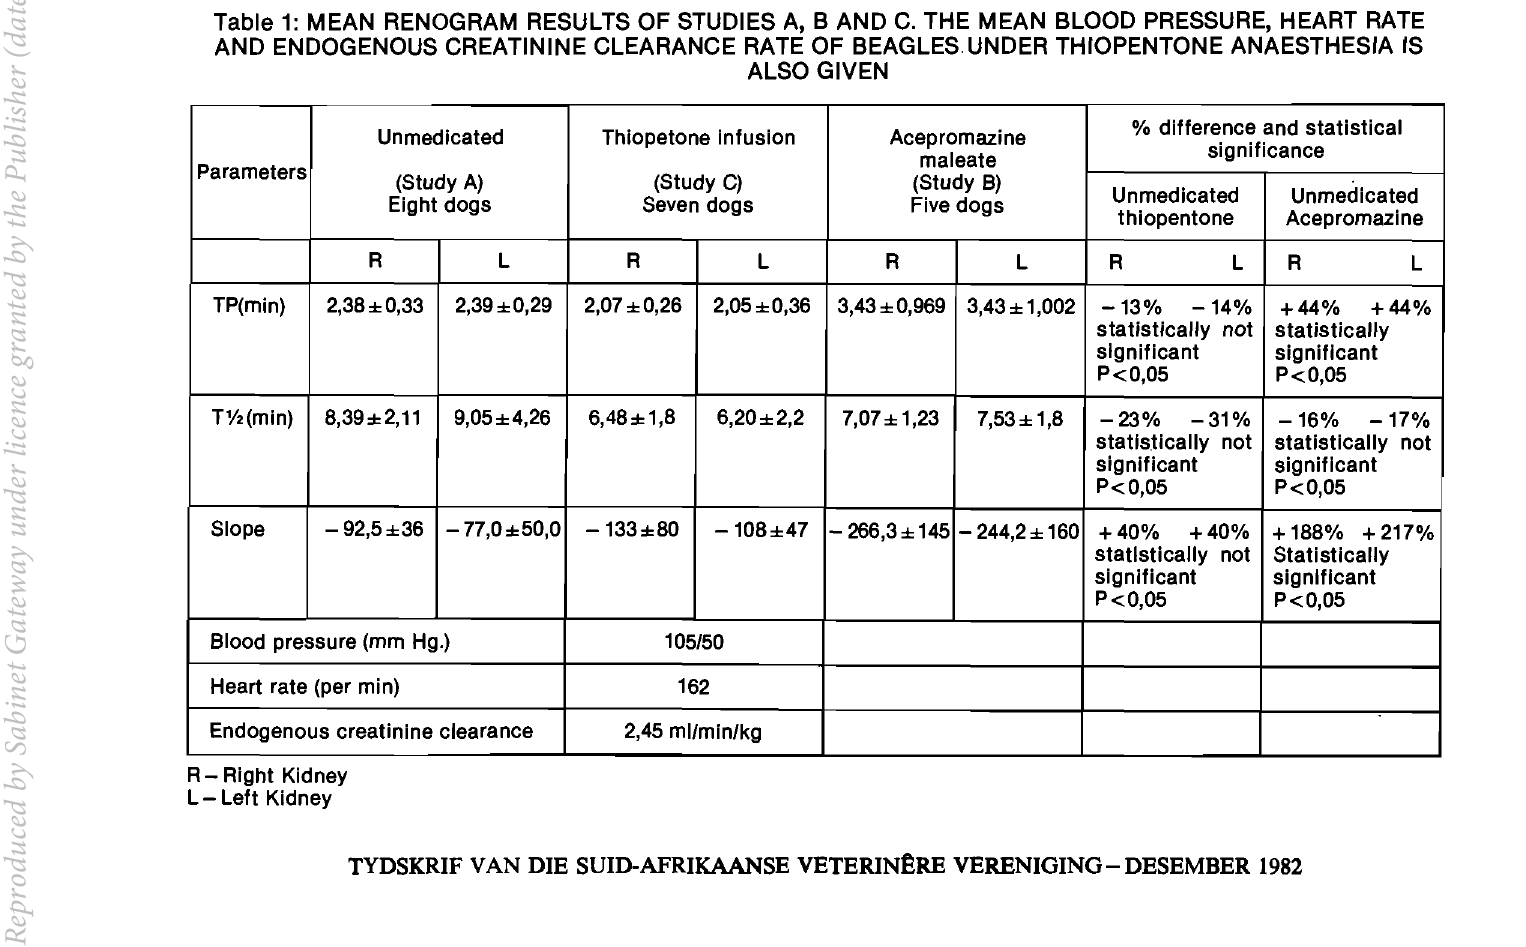
Table 1: MEAN RENOGRAM RESULTS OF STUDIES A, BAND C. THE MEAN BLOOD PRESSURE, HEART RATE AND ENDOGENOUS CREATININE CLEARANCE RATE OF BEAGLES. UNDER THIOPENTONE ANAESTHESIA IS ALSO